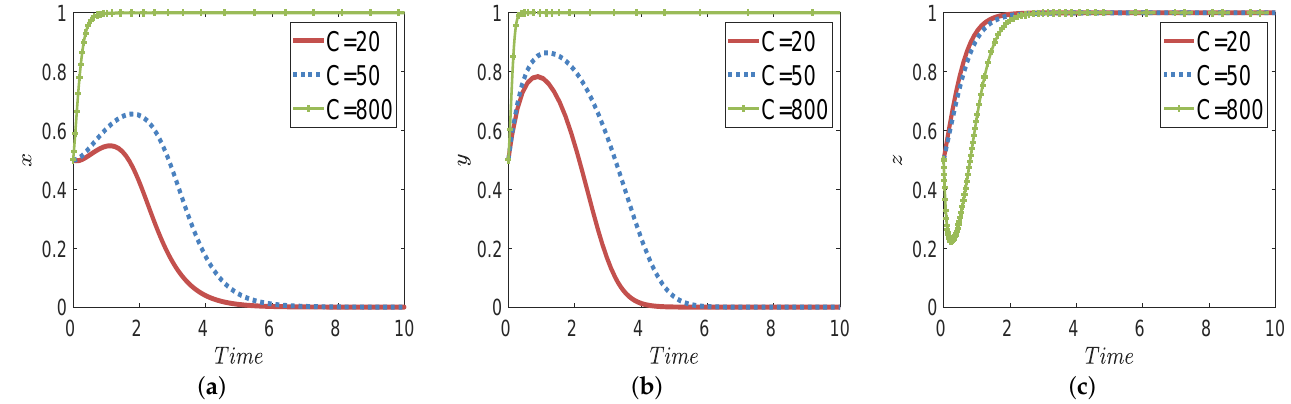
Figure 12. The impact of C on evolution: ( a ) crowd workers; ( b ) crowdsourcing platforms; ( c ) task